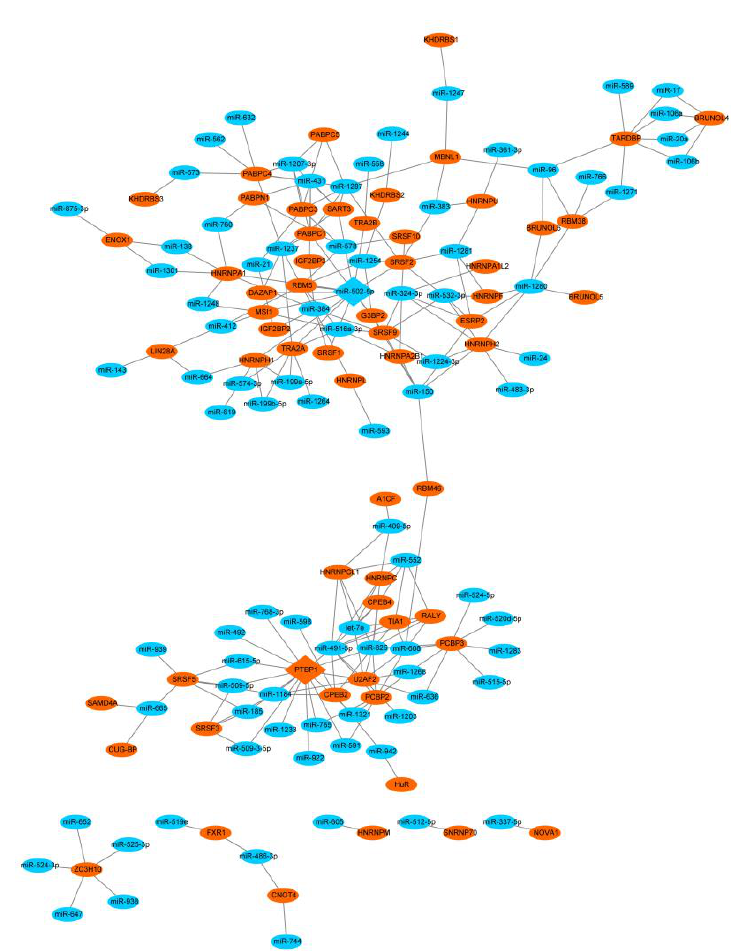
Figure 3. Global patterns of the competing miRNA and RBP pairs on human functional long non-coding RNA (lncRNAs). ( a ) The range of numbers of significant competing miRNA and RBP pairs for human functional lncRNAs. ( b ) the number of competing miRNA and RBP pairs is correlated with the sequence length of lncRNAs. ( c ) the interacting network of competing miRNAs and RBPs along MALAT1 sequence. Orange and blue circular nodes represent miRNAs and RBPs, respectively. Edges represent the competing relationships among them. Note that diamond nodes are the most connected miRNAs and RBPs in the